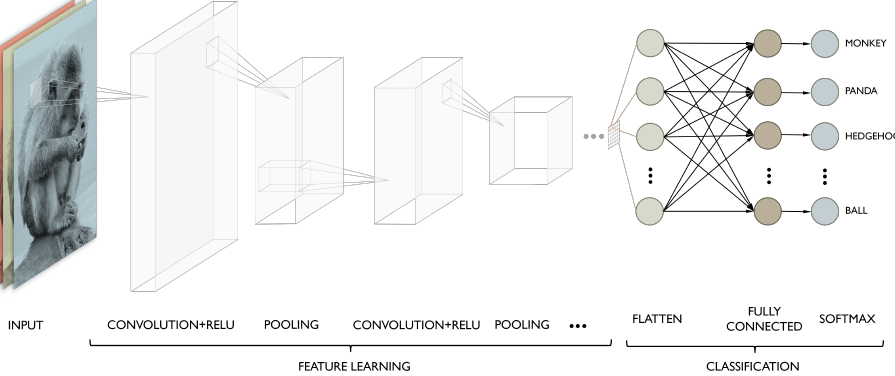
Figure 3. Configuration of a typical convolutional